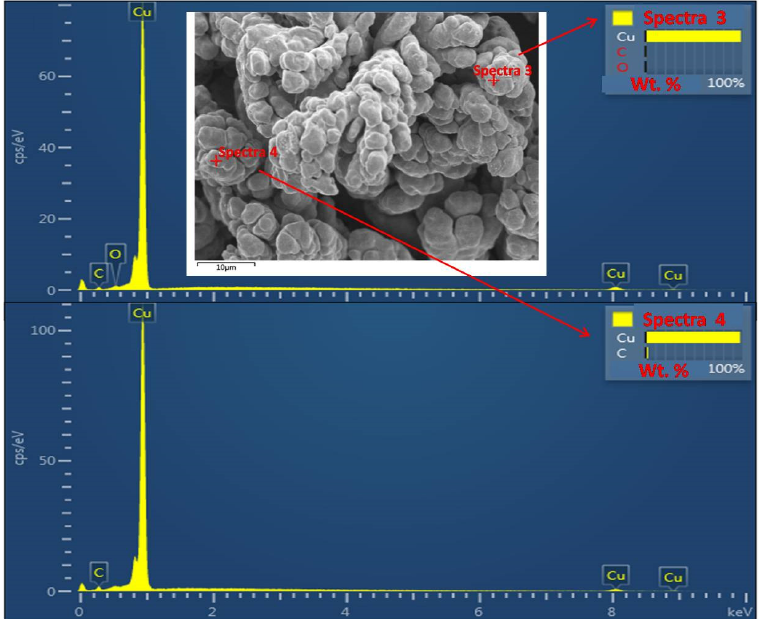
Figure 9. The EDS spectrum of reduced copper powder (reduction temperature 350 °C, time 135 min).